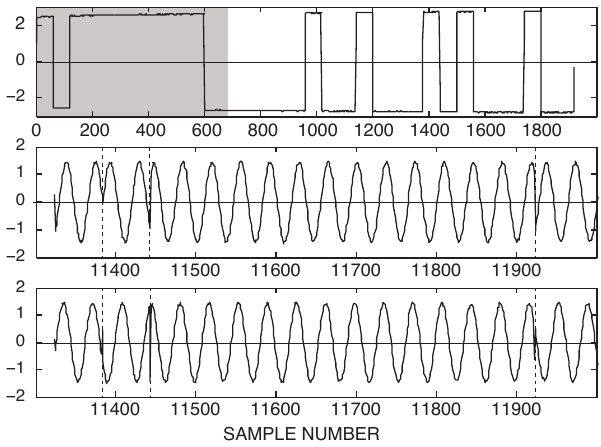
Fig. 1. Example of data from a single IPP. Top: Real part of the mod- ulation envelope. Middle: Real part of the echo pulse (only 680 first samples are shown). Bottom: Same as middle panel after demodula- tion. Grey shading in the top panel indicates the part of transmission corresponding to the part of the echo pulse in the other two panels. The vertical dashed lines in the middle and bottom panel indicate the positions of the 180 ◦ phase shifts caused by the modulation en-